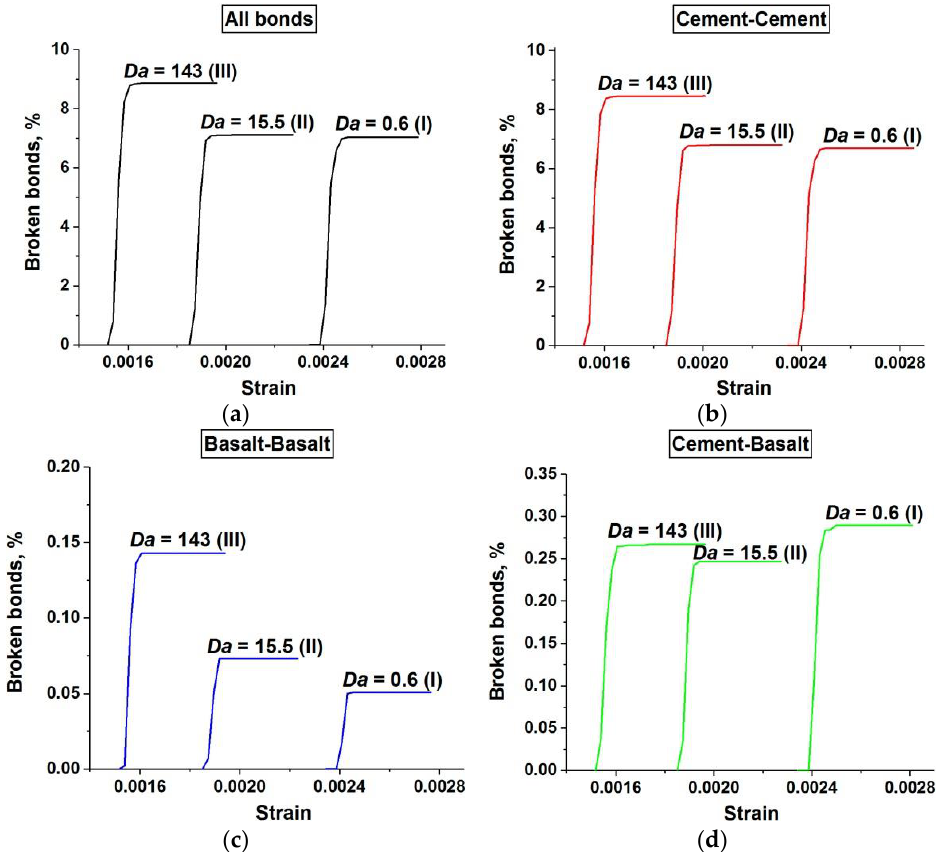
Figure 11. The dependences of the number of broken bonds in the fluid-saturated concrete sample with one-scale pore structure (capillary porosity) on the value of applied strain: ( a ) all broken bonds; ( b ) broken bonds in cement stone; ( c ) broken bonds in basalt aggregates; ( d ) broken bonds at the interphase boundaries. The number of broken bonds is normalized by the total number of bonds in the unstrained sample. Roman numerals I, II, and III denote the number of the corresponding section of the unified curve σ comp ( Da ).